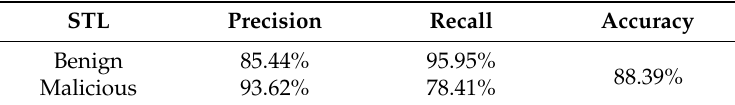
Table 7. Performance of self-taught learning (STL).